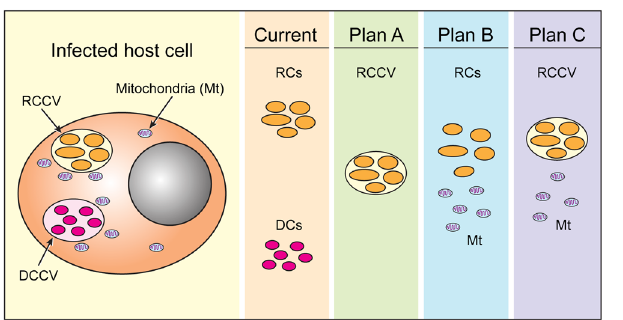
Figure 8. Proposed model to make improvements to the axenic media to promote E . chaffeensis replication in vitro in the absence of a host cell. RCCV and DCCV refer to RC containing and DC containing phagosome vacuoles,